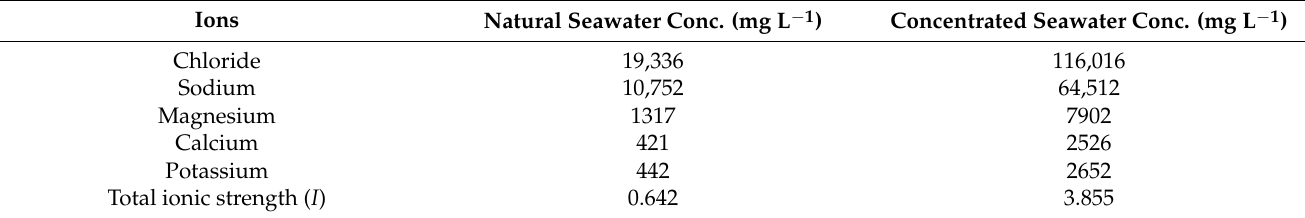
Table 1. Components of concentrated seawater.